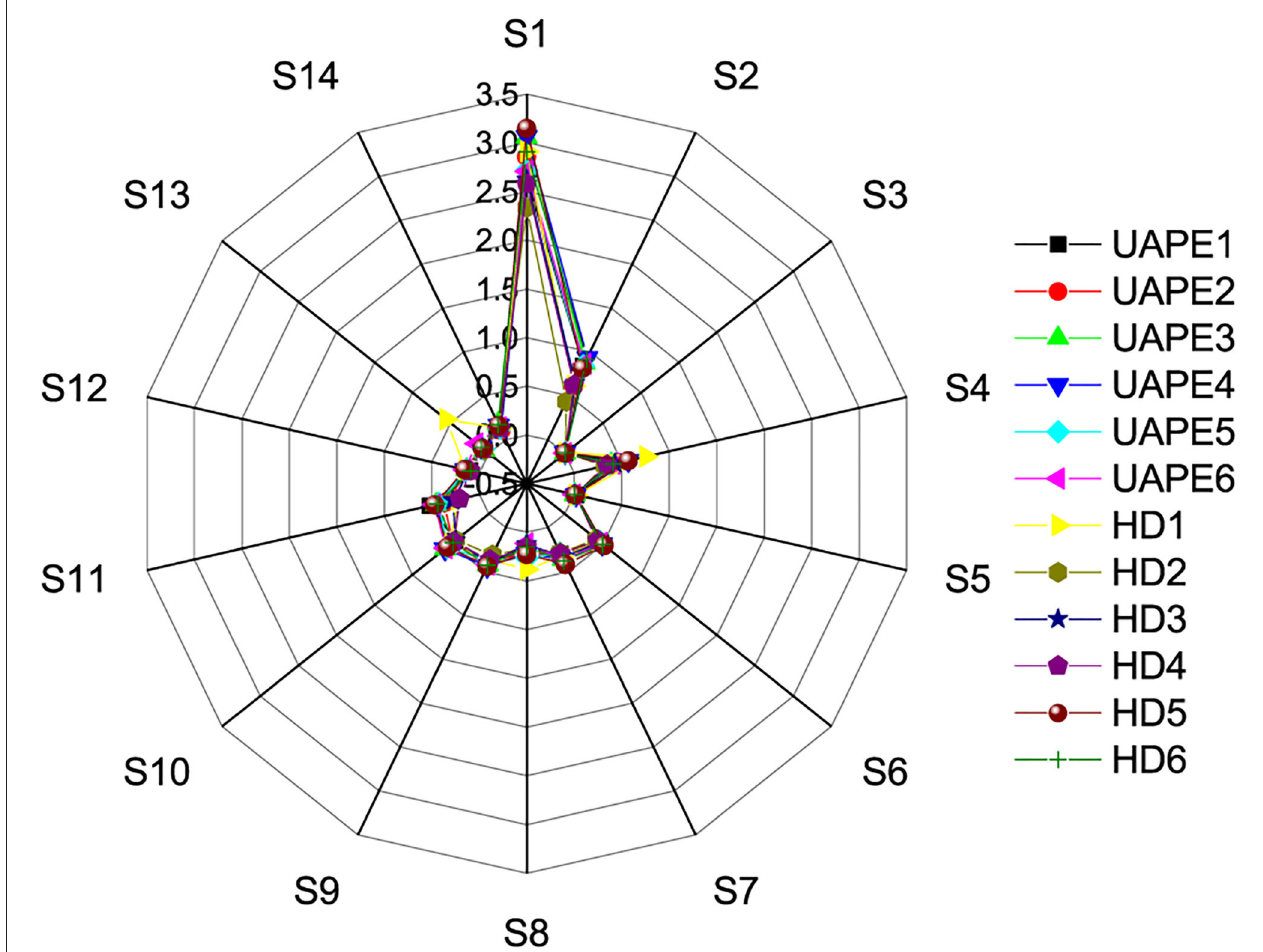
FIGURE 8 | Response graphs of 14 sensors for flavor compound from TCEO by the UAPE and HD methods.